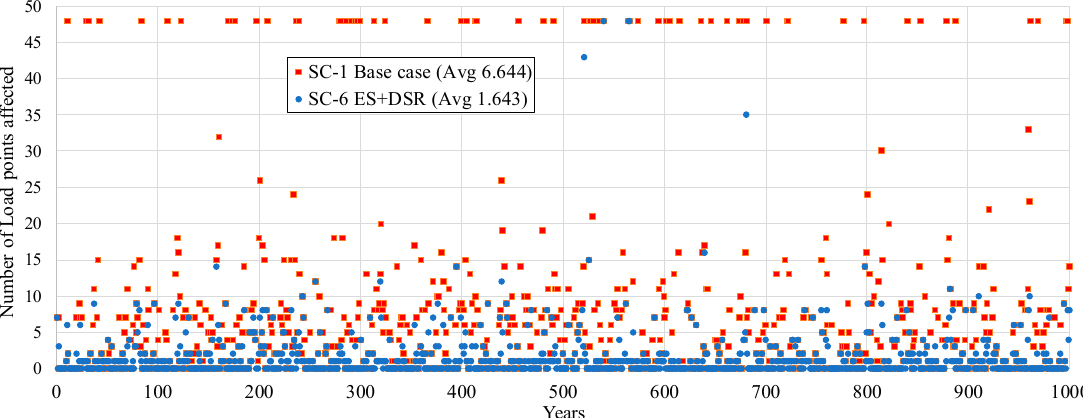
Figure 12. Number of load points affected by supply interruptions.